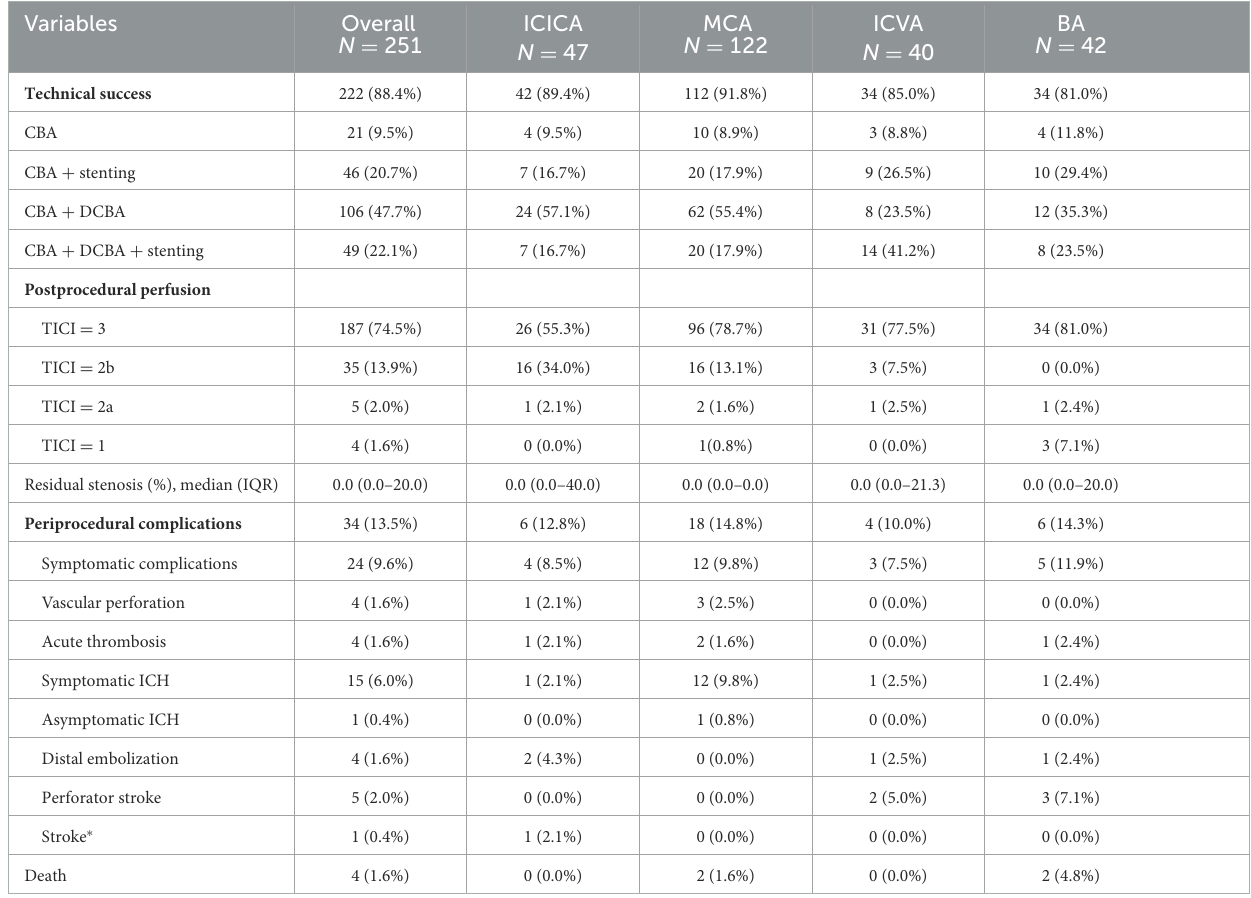
TABLE 2 Treatment modalities and pre-discharge outcomes of the